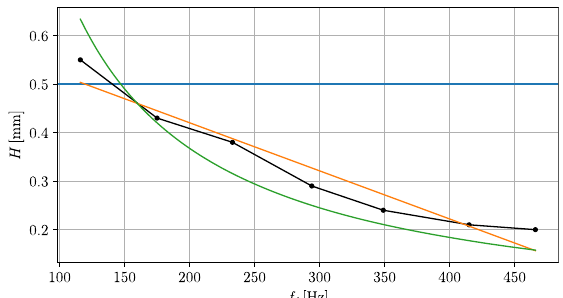
Figure 5. Considered H -pro fi les versus lips ’ resonance fre- quency. Blue line corresponds to the constant value of H = h 0 from [2], black points correspond to experimental data from [4], and the orange and green curves correspond to the regression functions chosen to fi t the experimental points, respectively H ¼ af b and H / 1 = f l l þ